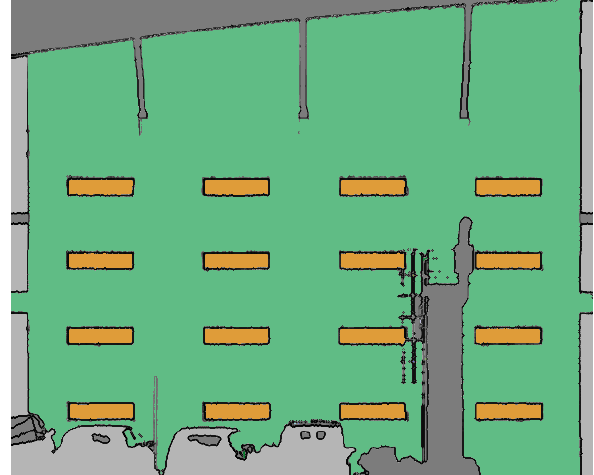
Figure 7: Polygonal shapes (in green and orange) identified from the analysis of the Blake-Zisserman model applied to the bound- aries of the homogeneous regions detected after the application of the Mumford-Shah model to the facade of Figure (4)